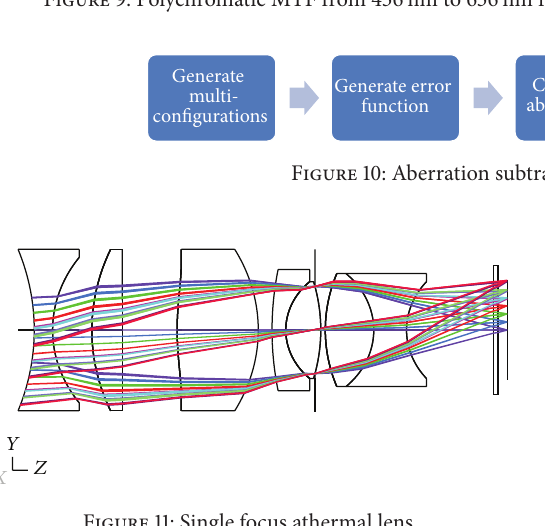
Figure 9: Polychromatic MTF from 436 nm to 656 nm for 2-meter object distance: (a) patent data and (b) final design.